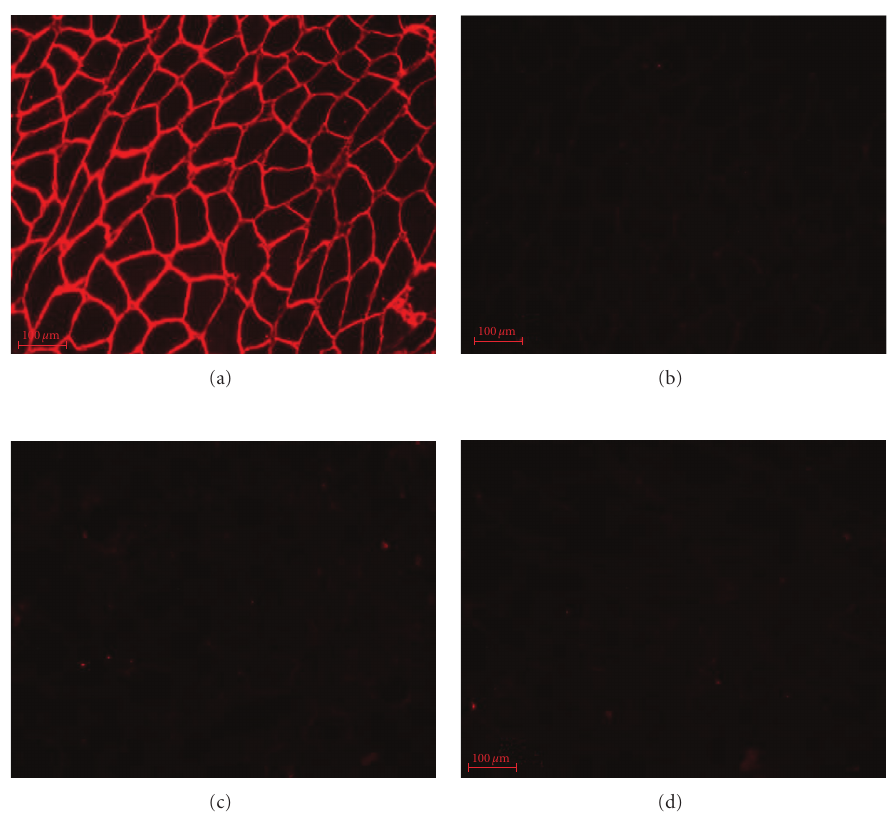
Figure 4: Human dystrophin expression analysis. Immunofluorescence using specific antihuman dystrophin antibody, Mandys106/2C6. (a) human normal muscle; (b) canine wild-type muscle; (c) B144 and (d) B312 from a ff ected female L3F2. Images were acquired with the same exposure time and magnification of